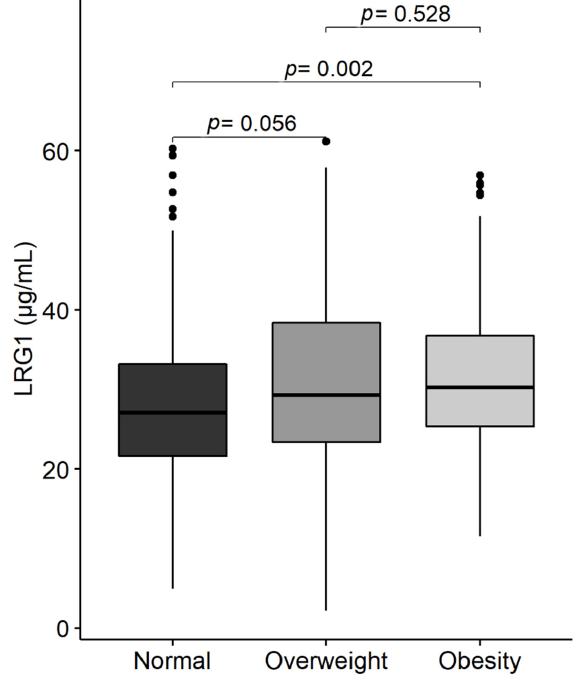
Figure 1. Distribution of LRG1 plasma level in normal-weight, overweight, and obese adolescents. Table 2. Association between overweight/obesity and LRG1 levels in univariable and multivariable multinomial logistic regression. Odds Ratio (OR) 1 Adjusted Odds Ratio (AOR) 3